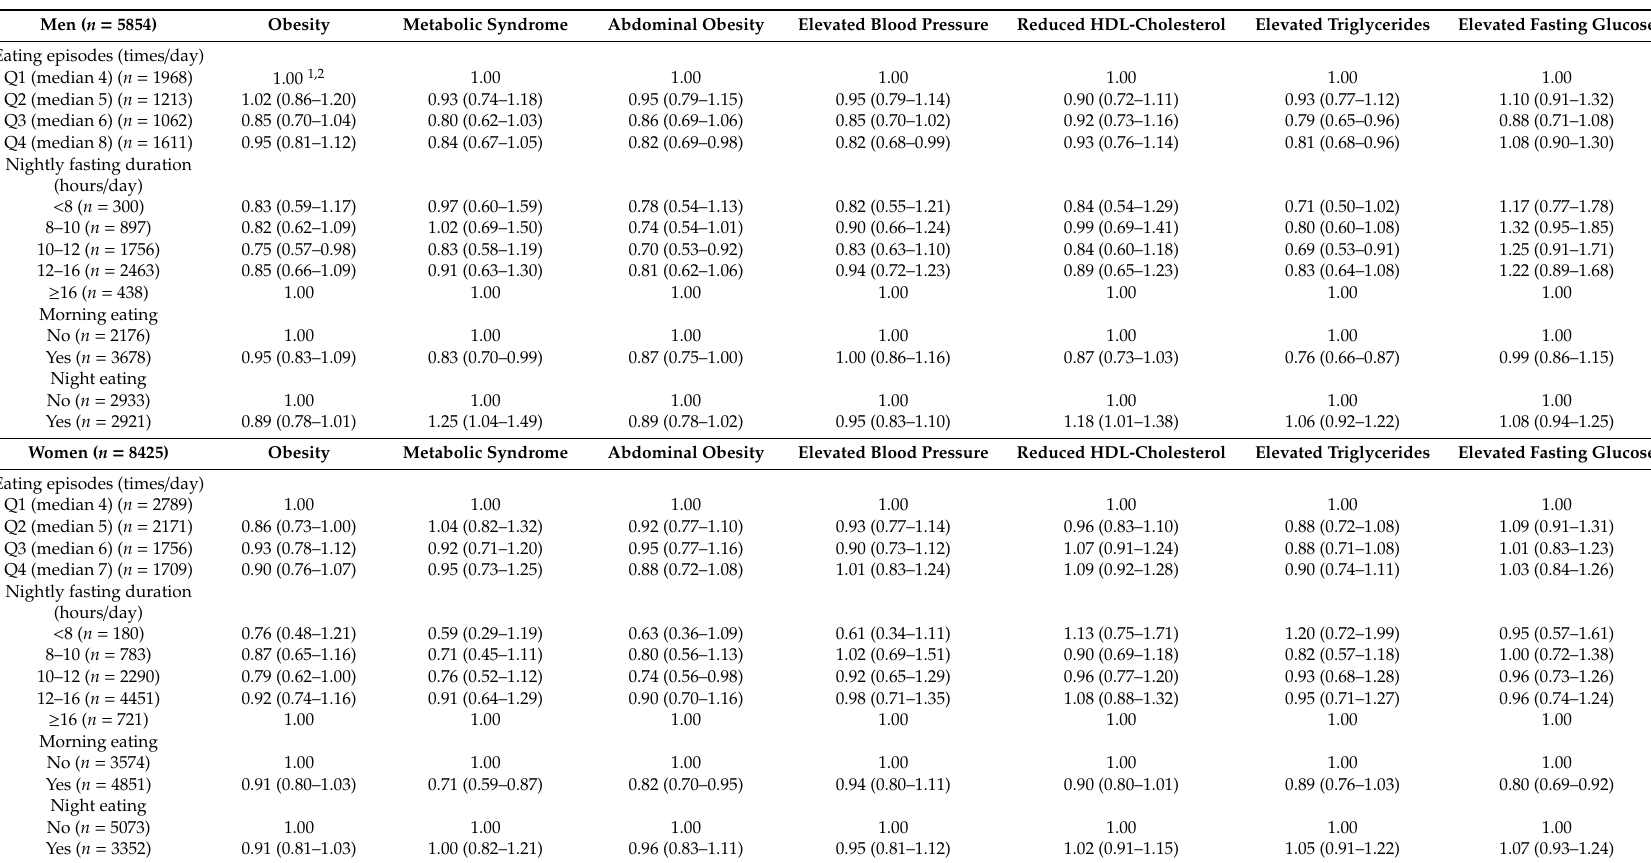
Table 2. Multivariable-adjusted odds ratios and 95% confidence intervals for obesity and metabolic syndrome according to meal timing and frequency. Obesity Abdominal Obesity Elevated Blood Pressure Reduced HDL-Cholesterol Elevated Triglycerides Elevated Fasting